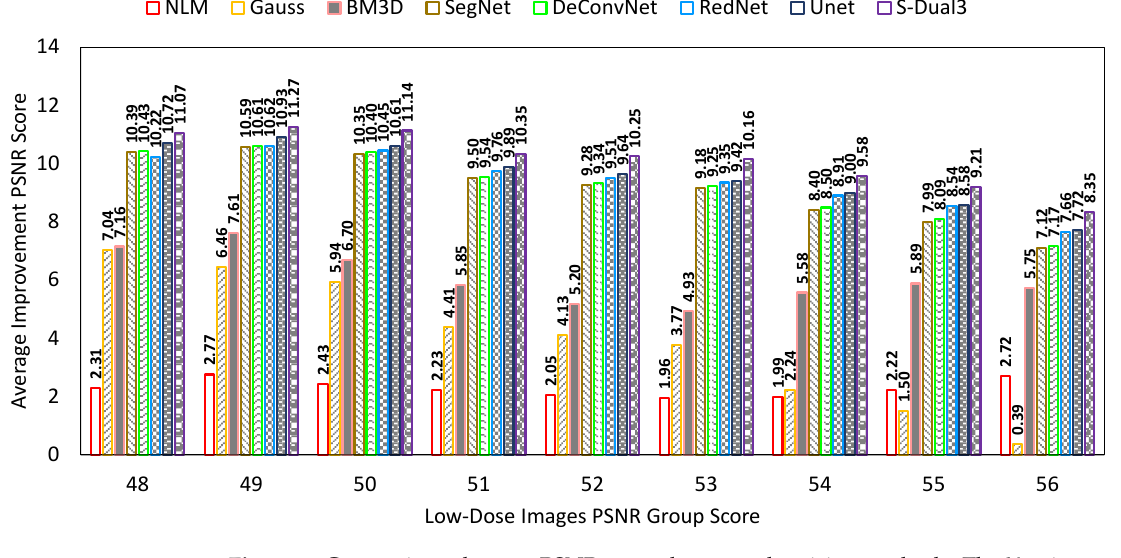
Figure 9. Comparison chart on PSNR scores between denoising methods. The X-axis represents the PSNR scores of the low-dose images in groups, while the Y-axis represents the amount of PSNR score improvement. Greater improvement indicates a better image quality. The SSIM comparison chart (Figure 10) has the same presentation as the previous two charts. The S-Dual3 method was best with 0.00895 points of improvement, followed with RedNet (0.00873), DeConvNet (0.00872), U-Net (0.0087), SegNet (0.0087), BM3D (0.00731), Gauss (0.00452), and NLM (0.00365).